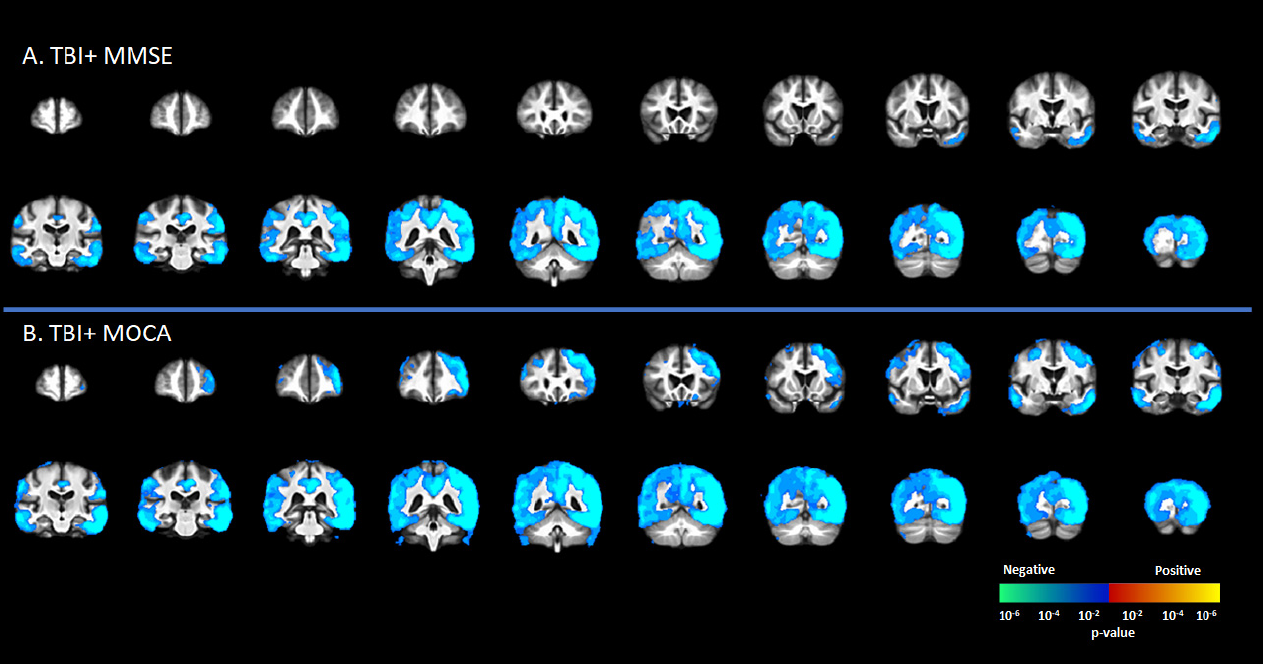
Figure 3. Correlation between [ 18 F]-AV1451 SUVr maps and different cognitive test scores in the elderly population with a self-reported history of traumatic brain injury (TBI), with results showing negative correlations between tau deposition and ( A ) mini-mental state scale (MMSE) and ( B ) Montreal cognitive assessment (MOCA). Red-yellow represents a positive correlation between tau accumulation in people with self-reported history of TBI and cognitive scores, while blue-green represents negative correlation between tau accumulation and cognitive scores.